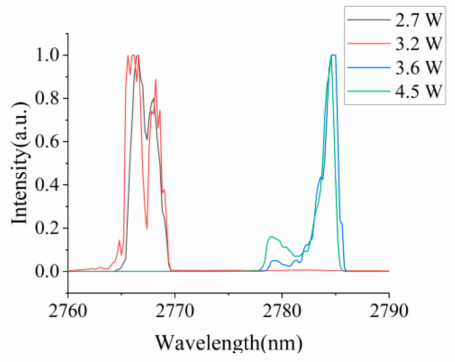
Figure 2. Output spectrum at different pump powers in Case 1.